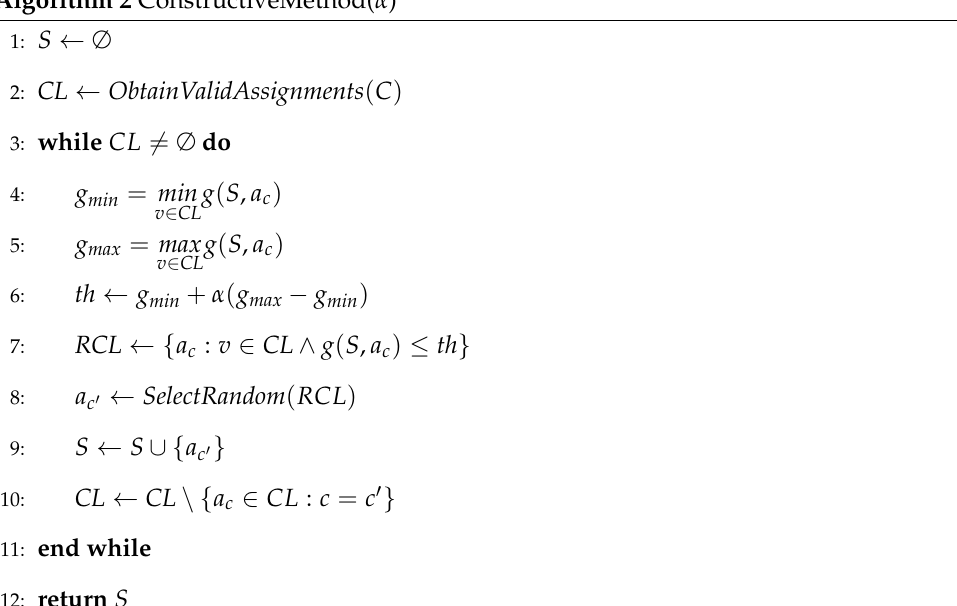
Algorithm 2 ConstructiveMethod( α